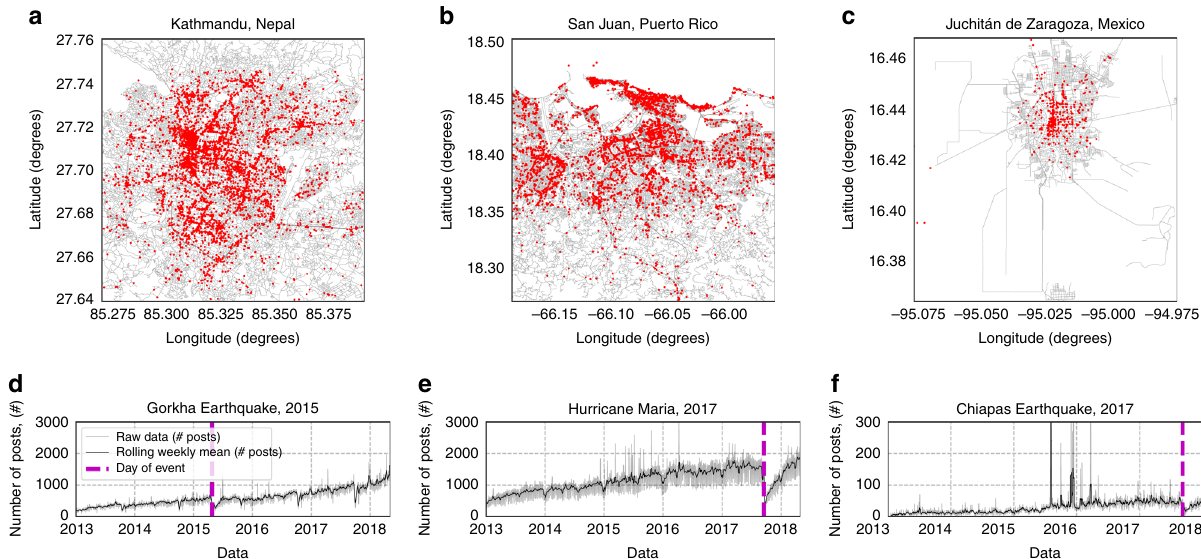
Fig. 1 Businesses locations on Facebook with aggregate posting activity. a – c Regions in which Facebook posts have been collected, each business highlighted in red, road networks collected from OpenStreetMap 39 (OpenStreetMap contributors, OpenStreetMap data is available under the Open Database License and licensed as CC BY-SA https://creativecommons.org/licenses/by-sa/2.0/) using OSMnx 40 . d – f Time series for the total number of posts made by all businesses in each region. The magenta vertical dashed lines denote the date of the natural hazard